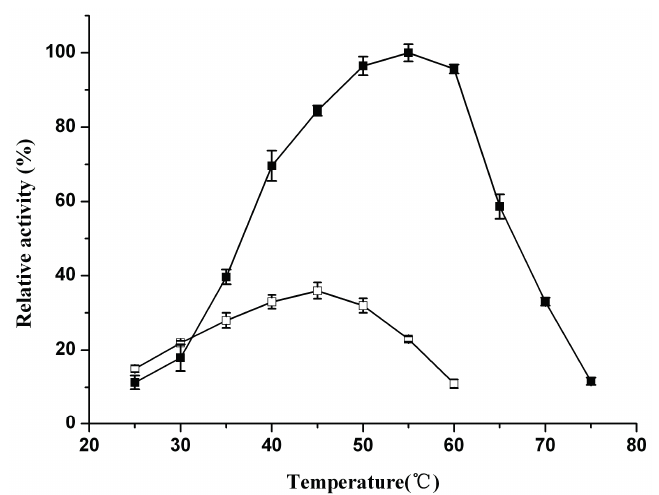
Figure 3. Effect of temperature on the activities of ReBDH. The relative activity of 100% represents 11.3 U/mg for acetoin reduction at 55 °C and pH 6.5. Solid symbols, ketone reduction; empty symbols, alcohol oxidation.